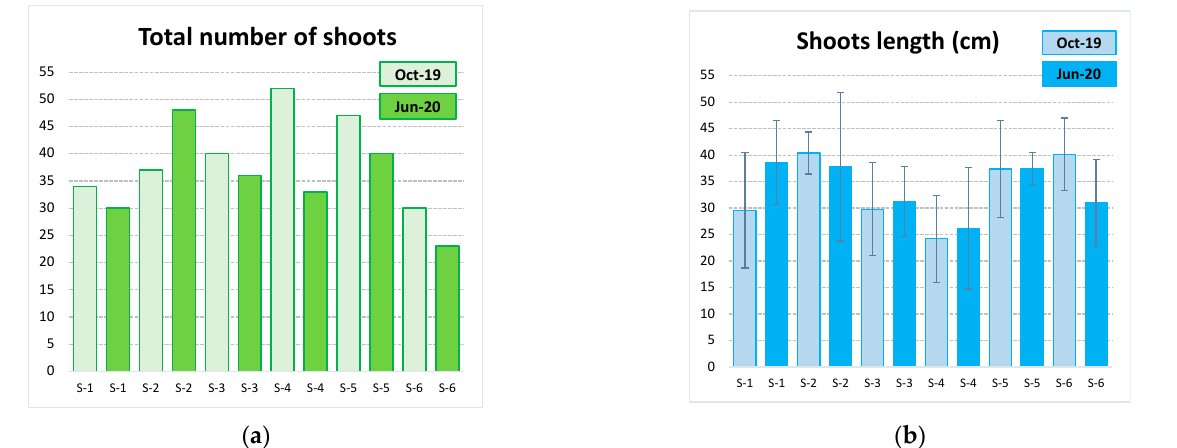
Figure 12. Total number of shoots ( a ) and average values of shoot length ( b ) of the 6 monitored supports in October 2019 and in June 2020.